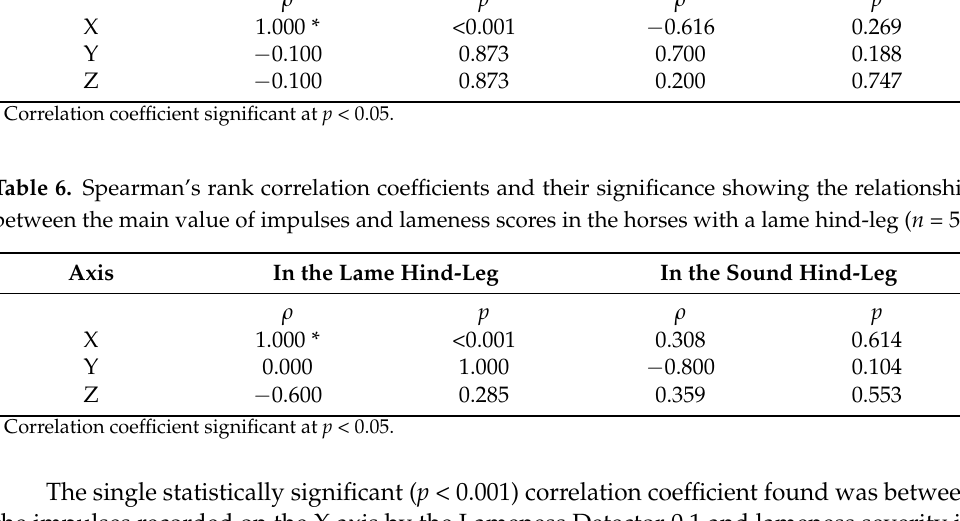
Table 5. Spearman’s rank correlation coefficients and their significance showing the relationship between the main value of the impulses and lameness scores in the horses with a lame foreleg ( n = 5). Axis In the Lame Foreleg In the Sound Foreleg ρ p ρ p X 1.000 * <0.001 − 0.616 0.269 Y − 0.100 0.873 0.700 0.188 Z − 0.100 0.873 0.200 0.747